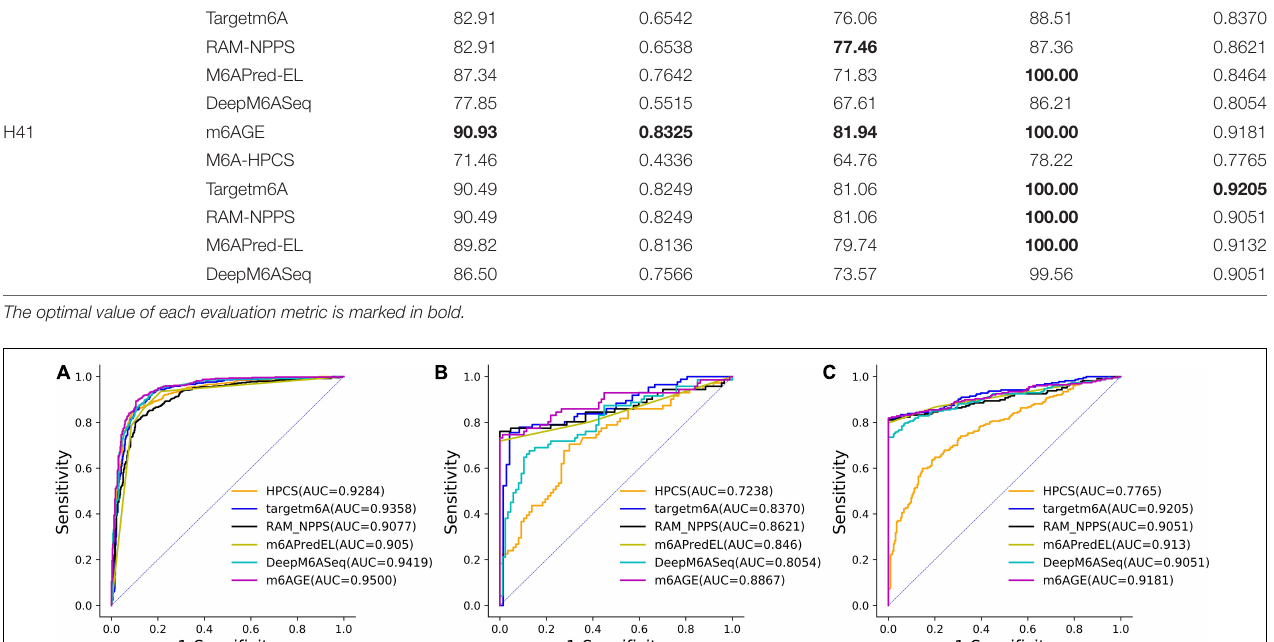
Frontiers in Genetics |